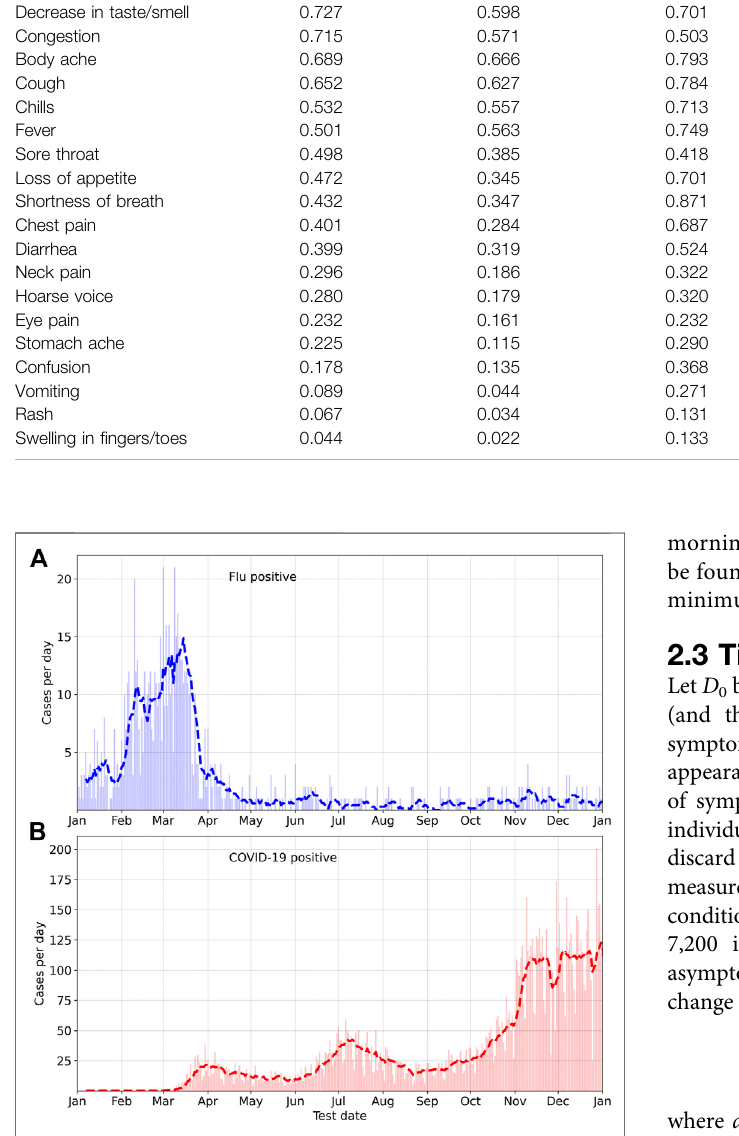
Frontiers in Physiology |